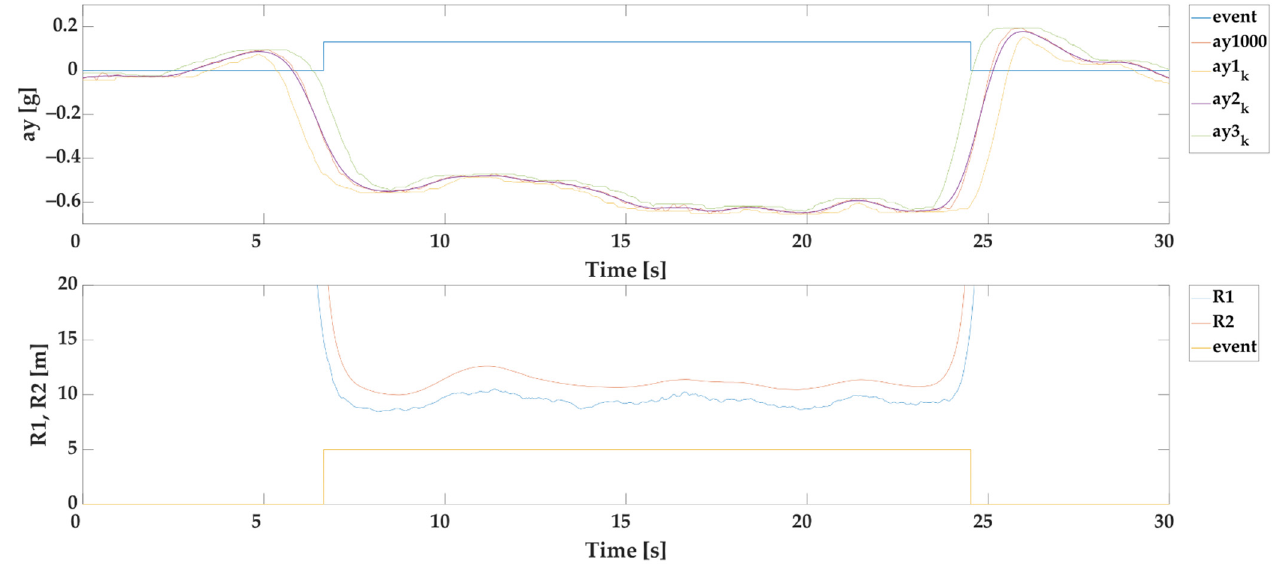
Figure 4. Example of automatic selection of events based on MSE of R 1 and R 2. Only events with MSE ≤ 16 and minimum duration of event 1 s are further